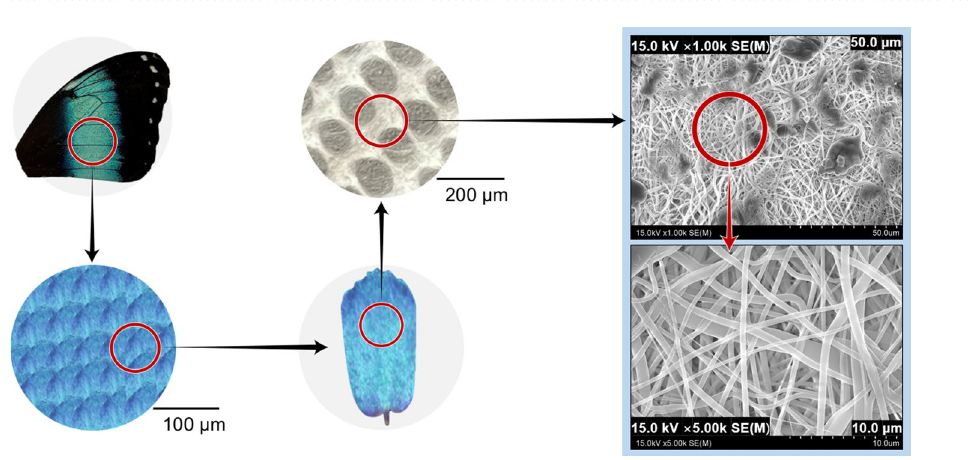
Figure 8. Final microstructure of the electrospun